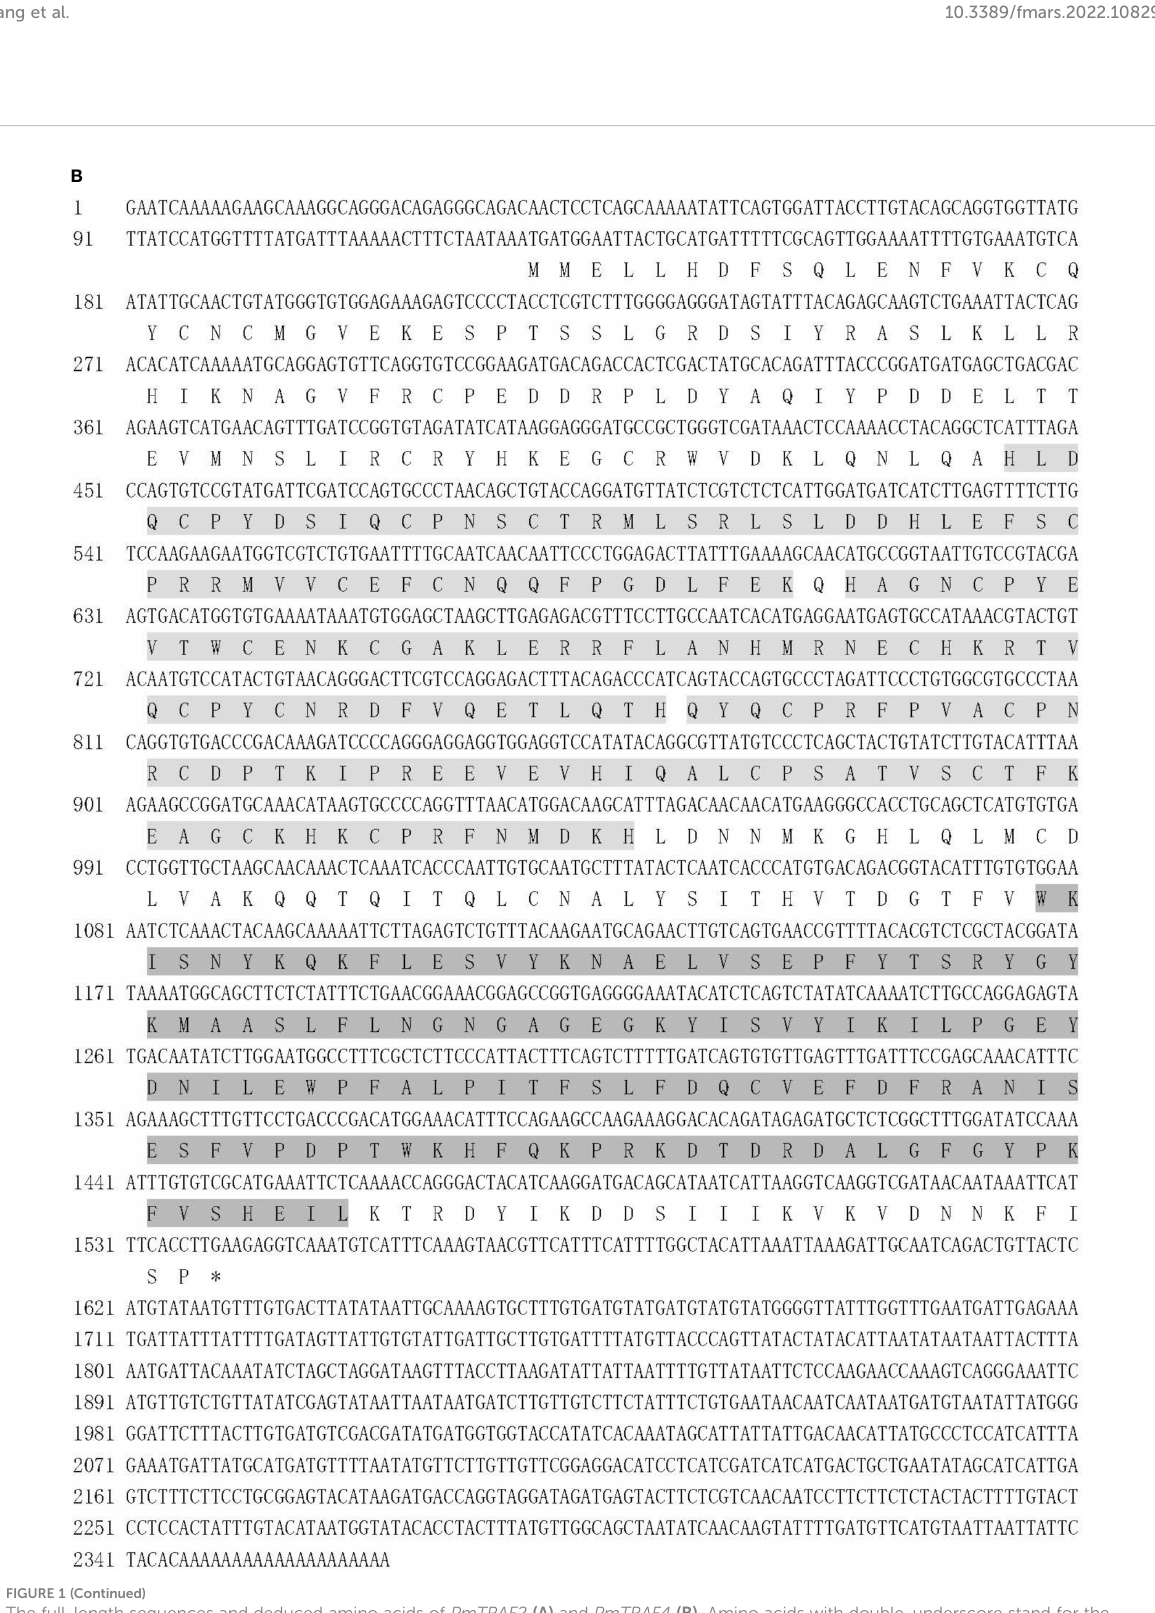
FIGURE 1 (Continued) The full-length sequences and deduced amino acids of PmTRAF2 (A) and PmTRAF4 (B) . Amino acids with double-underscore stand for the RING fi nger domain, light shadows for the TRAF-type zinc fi nger domain, light shadows with boxes for the TRAF_BIRC3_bd domain, and deep shades of gray for the MATH domain. * indicates the translation stop